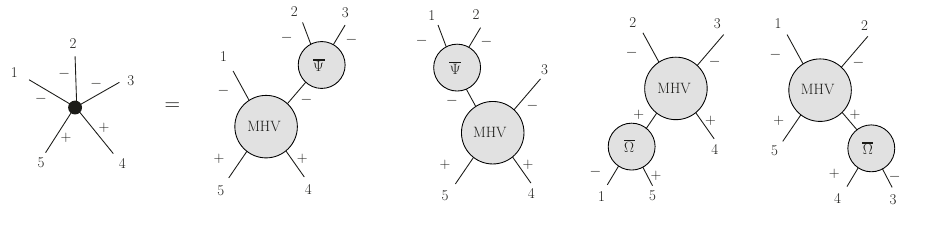
Figure 3 . The contributions to the color-ordered MHV vertex, with helicity ( − − − + +) .